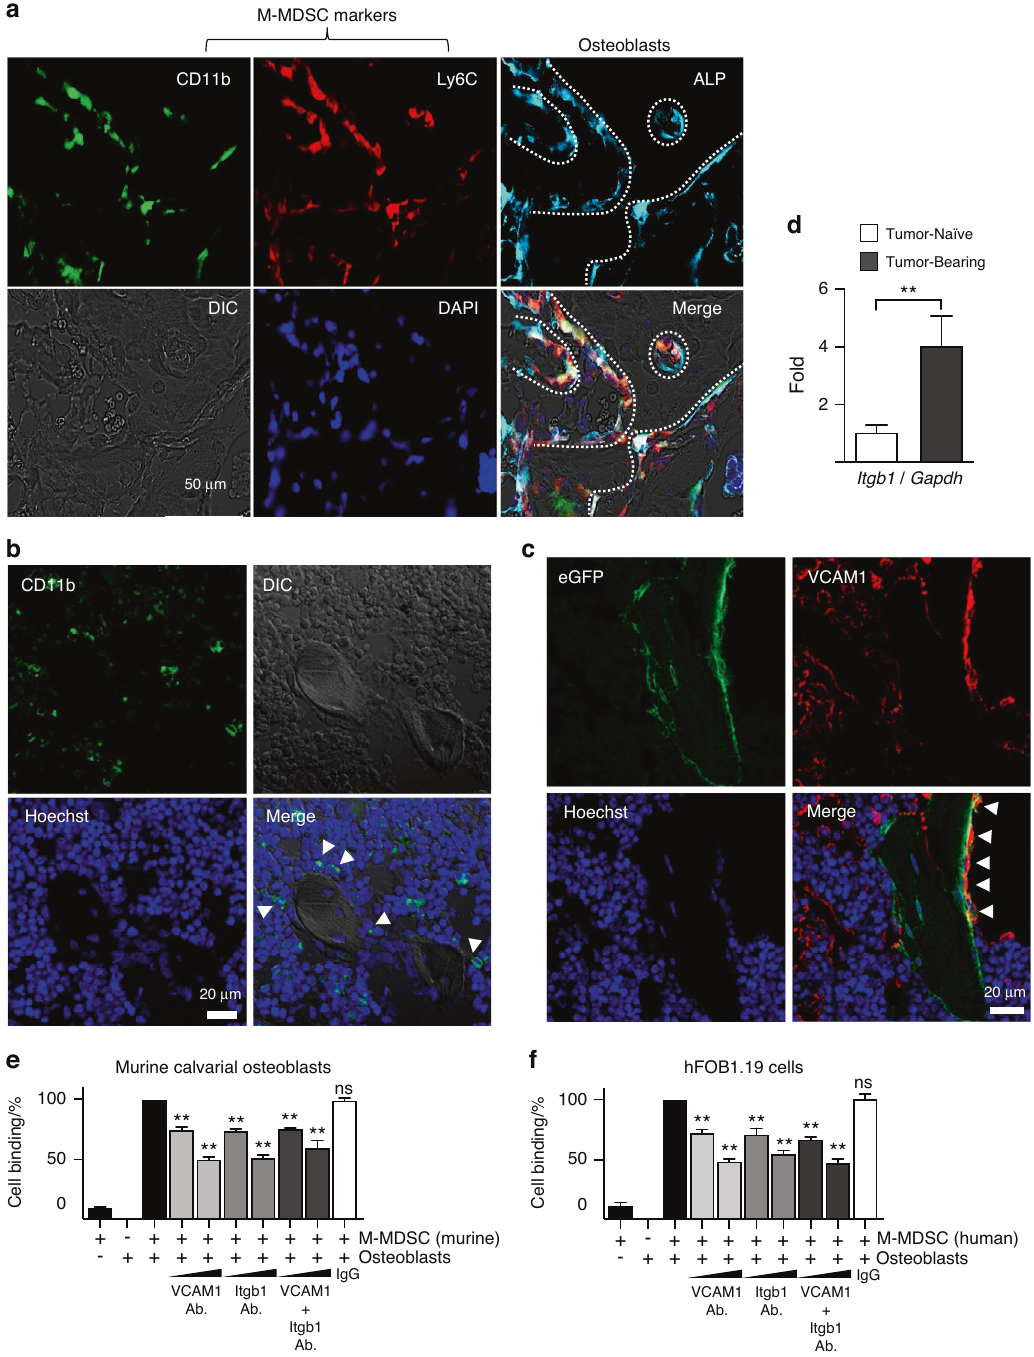
Fig. 4 M-MDSCs reside in the endosteal surface of bone marrow via VCAM1 and Integrin β 1. a Immuno fl uorescence staining of the tibia of Balb/c female mice with 4T1 breast cancer bone metastasis. White dotted lines indicate the endosteal surface. Anti-mouse CD11b (green), anti-Ly6C (red) and anti-ALP (teal) antibodies were labeled with Alexa Fluor 488, Alexa Fluor 594 and Cy5.5 fl uorescence dye, respectively. Images were captured using a fl uorescence microscope (EVOS FL Auto 2). b Immuno fl uorescence staining of the tibia of 4T1 tumor-bearing Balb/c mice. CD11b (green)-positive cells were imaged and overlaid with differential interference contrast (DIC) and Hoechst 33342 counterstained images. Some CD11b-positive cells are localized close adjacent to endosteal lining cells (indicated with white triangles). Images were captured using a confocal microscope (Zeiss LSM-900). c Immuno fl uorescence staining of the tibia of Osteocalcin ( Ocn )- Cre : ROSA mT/mG reporter female mice carrying B16F10 tumors. Osteocalcin (Ocn, green) and VCAM1 (Alex Fluor 647, red) expression colocalized (indicated by white triangles), supporting that endosteal lining osteoblasts express VCAM1. Hoechst 33342 (blue) counterstaining for nuclei. Images were captured using a confocal microscope (Zeiss LSM-900). d Expression of β 1 integrin mRNA measured by RT ‒ qPCR in M-MDSCs isolated from the bone marrow of 4T1 tumor-bearing tibia. CD11b + Ly6C + Ly6G − cells from untreated tumor-naïve mice were used as controls. Data are the mean ± SEM ( n = 5 per group). ** P < 0.01, Student ’ s t test. e , f In vitro cell binding assay showing that VCAM1 or integrin β 1 neutralizing antibodies (1 or 2 μ g·mL − 1 ) block M-MDSC and murine ( e ) or human ( f ) osteoblast binding. Nonspeci fi c IgG was used as a control. Data are the mean ± SEM ( n = 5 per group). ** P < 0.01, one-way ANOVA with multiple group